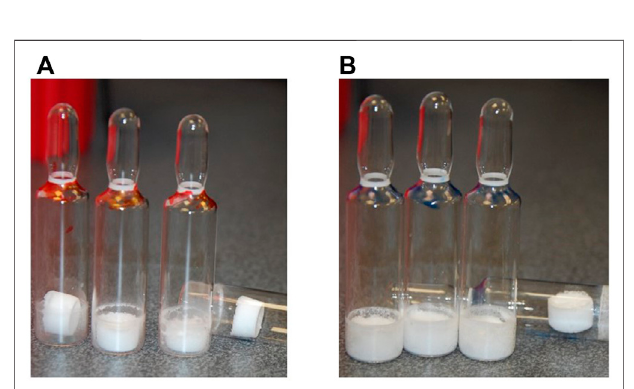
FIGURE 3 | SS-889 FD options (A) without NaCl and (B) with NaCl (SS-889).